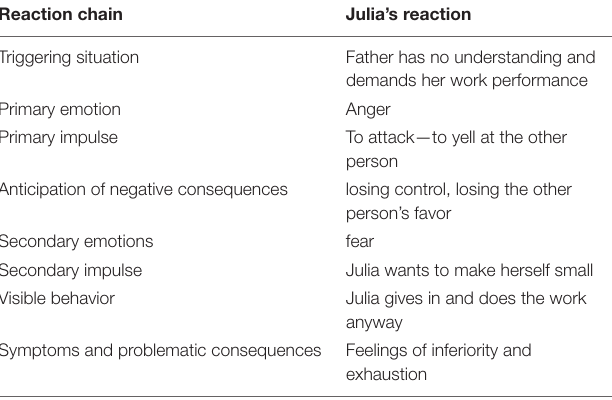
TABLE 2 | Julia’s reaction chain.